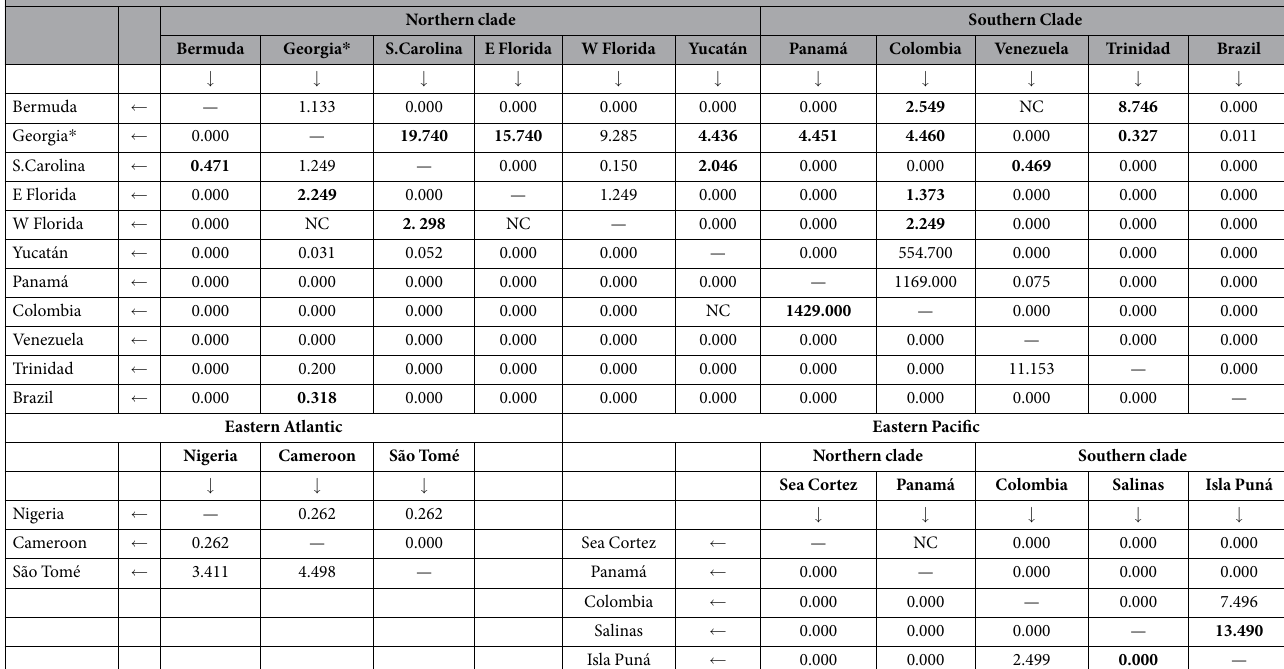
Table 4. Rates of migration within each region estimated from the IMa2 algorithm 111 . Number of female propagules (2N f m) received by the population listed in first column from population listed in first row (in the direction of the arrows). NC: IMa2 failed to converge. Values are based on the concatenated fragment of 16S, COI-af and COI-HL, except for comparisons between Georgia (marked with asterisk) and the rest of the populations, which are based on COI-HL alone. Migration rates that were not significantly different from 0 are shown as “0.000”. Bold values indicate significantly asymmetrical gene flow. Clades as defined in Fig.